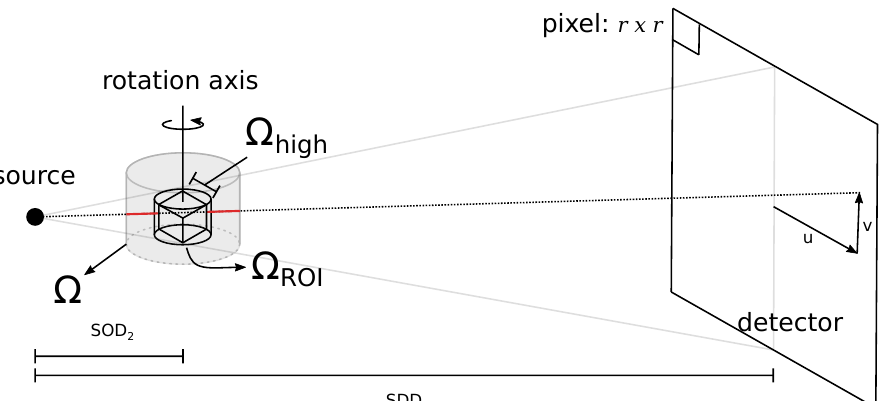
Figure 3. An illustration of the second tomographic scan. The object, supported on Ω , is scanned at magnification α high = SDD / SOD 2 . Now, only the region of interest, Ω ROI , is always in full view of the detector. The high-resolution reconstruction grid x high is thus constrained to the rectangular volume Ω Ω high . Part of the object outside of high contributes to the acquired projection data. This is highlighted in